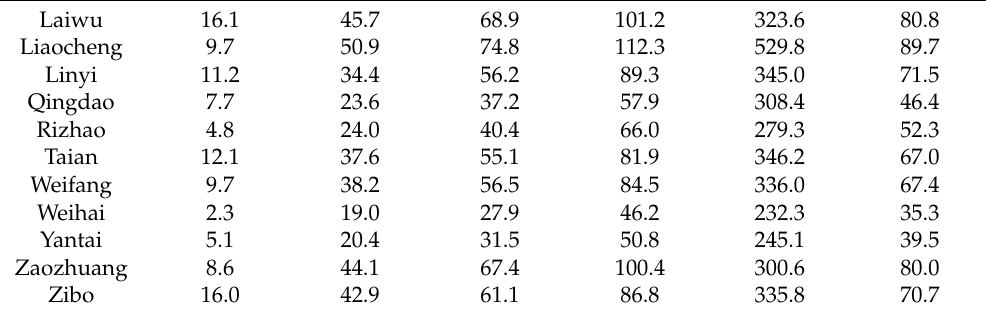
Table A2. Descriptive statistics of the daily mean PM 10 levels ( µ g/m 3 ) in the 17 cities of the Shandong province (from 1 January 2015 to 31 December 2016).